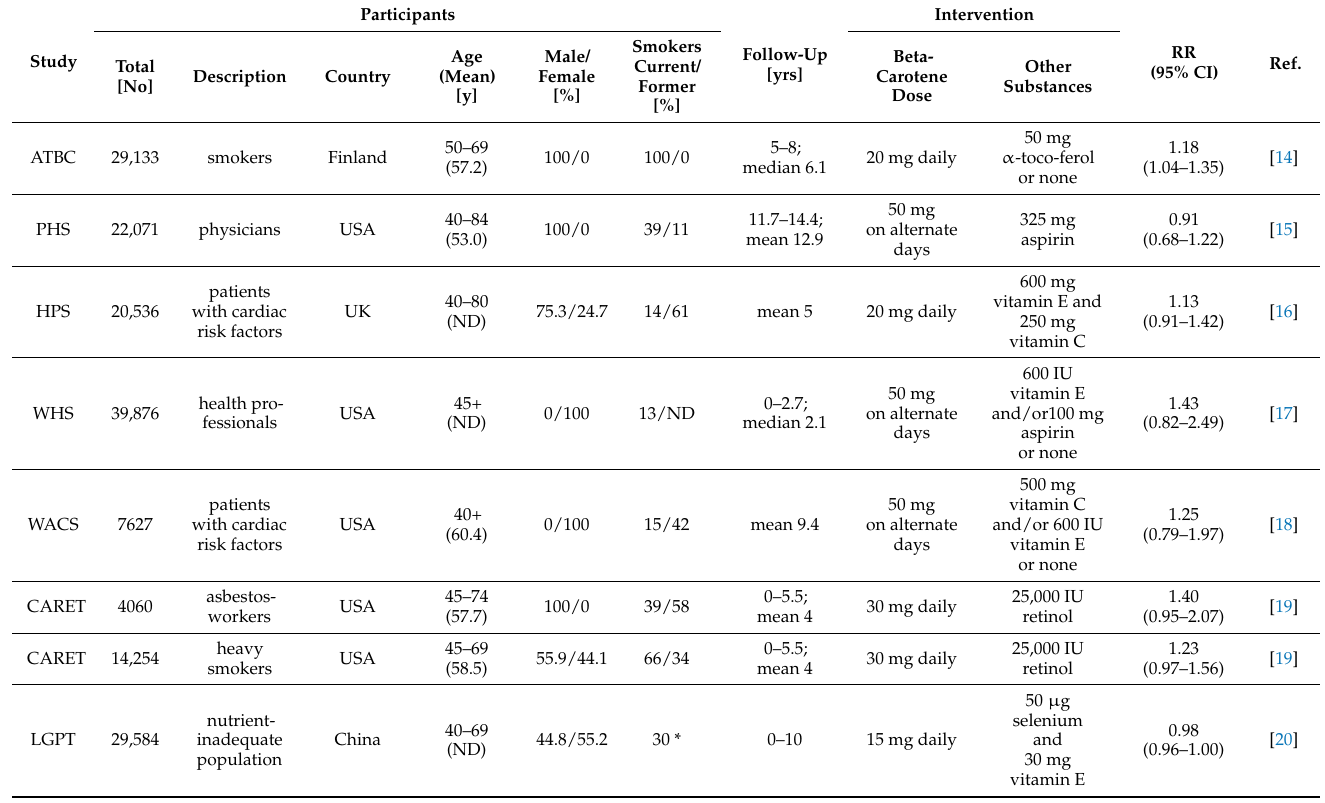
Table 2. Characteristics of included studies for systematic